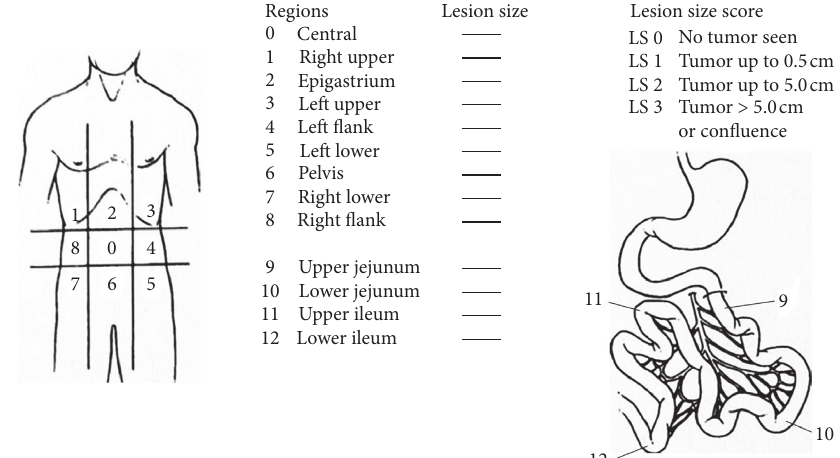
Figure 1: Peritoneal cancer index [4].